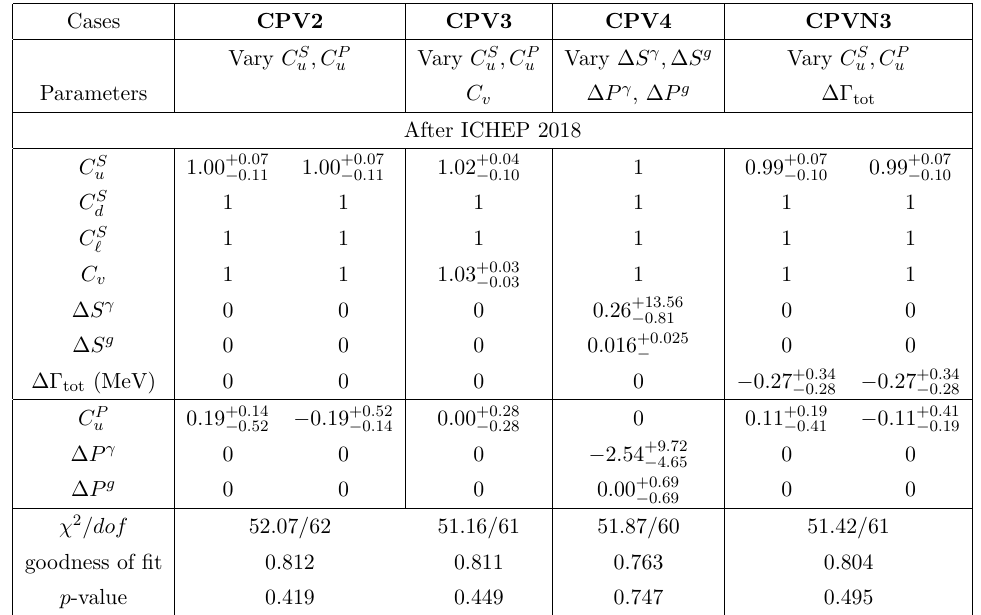
Table 8 . CPV : the best-(cid:12)tted values in various CP violating (cid:12)ts and the corresponding chi-square per degree of freedom and goodness of (cid:12)t. The p -value for each (cid:12)t hypothesis against the SM null hypothesis is also